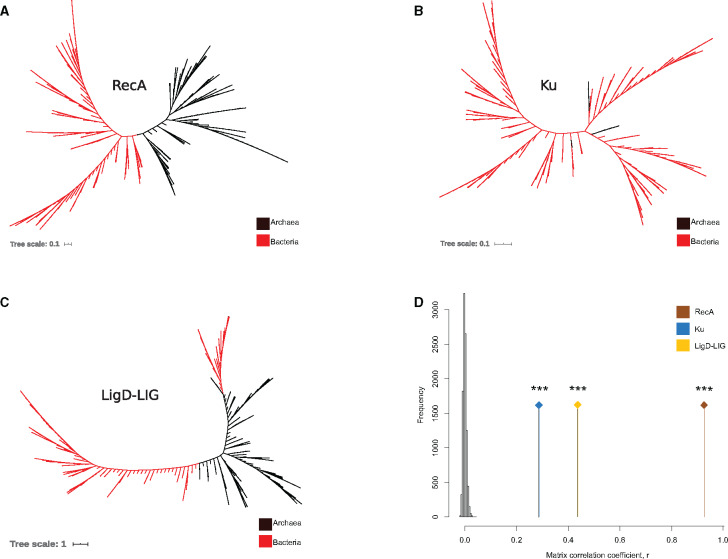
Phylogenetic methods suggest a strong role of HGT in NHEJ evolution. (A) Unrooted RecA tree, (B) unrooted Ku tree, (C) unrooted LigD-LIG tree, and (D) Mantel test correlation coefficient (r) comparing RecA, Ku, and LigD-LIG distance matrices with 16S rRNA distance matrices, respectively, compared against a null distribution of r obtained by 10,000 matrix randomizations.